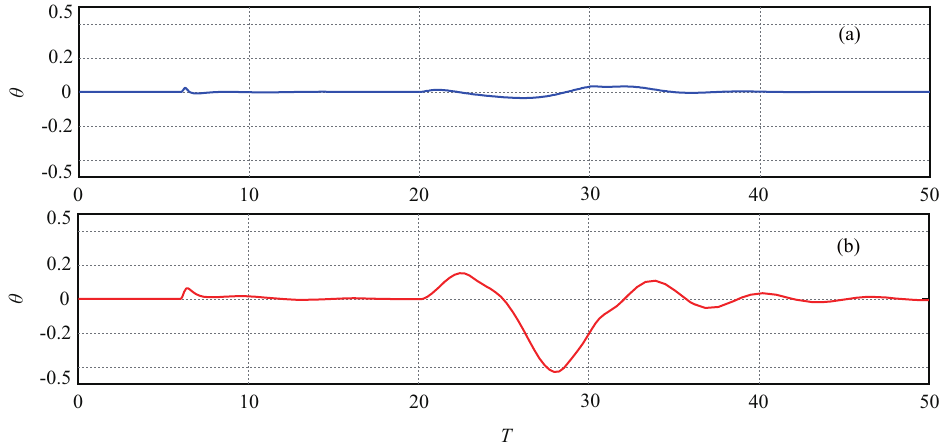
Figure 7. Robustness test results of the ball rotational angle under different external disturbances [( a ) Proposed method; ( b ) Method in